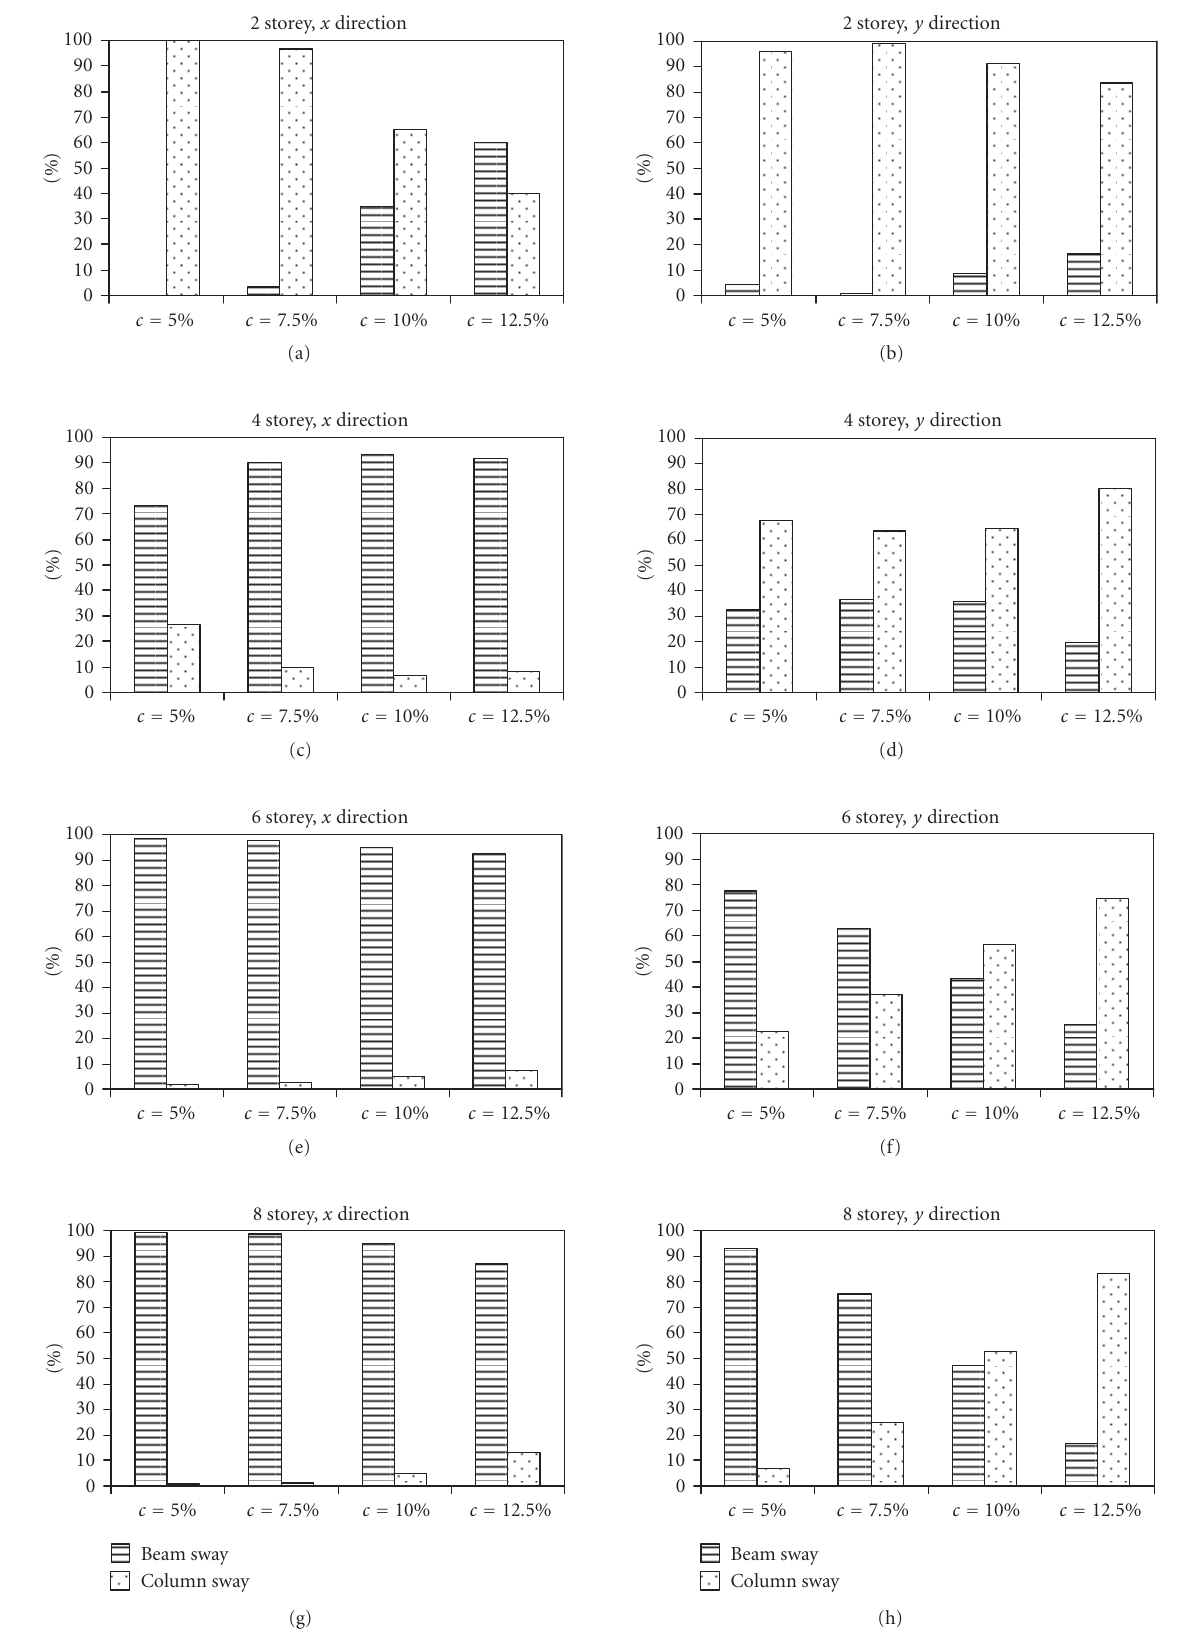
Figure 14: Percentage of beam-sway and column-sway mechanisms in SP-BELA for the prototype